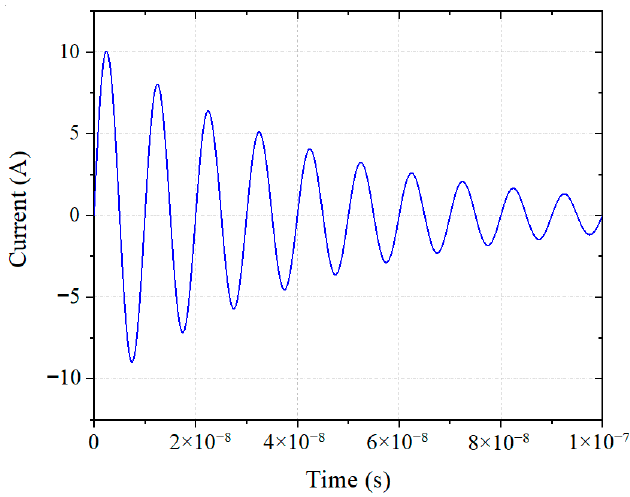
Figure 3. Pulse current injecting signal at 100 MHz.